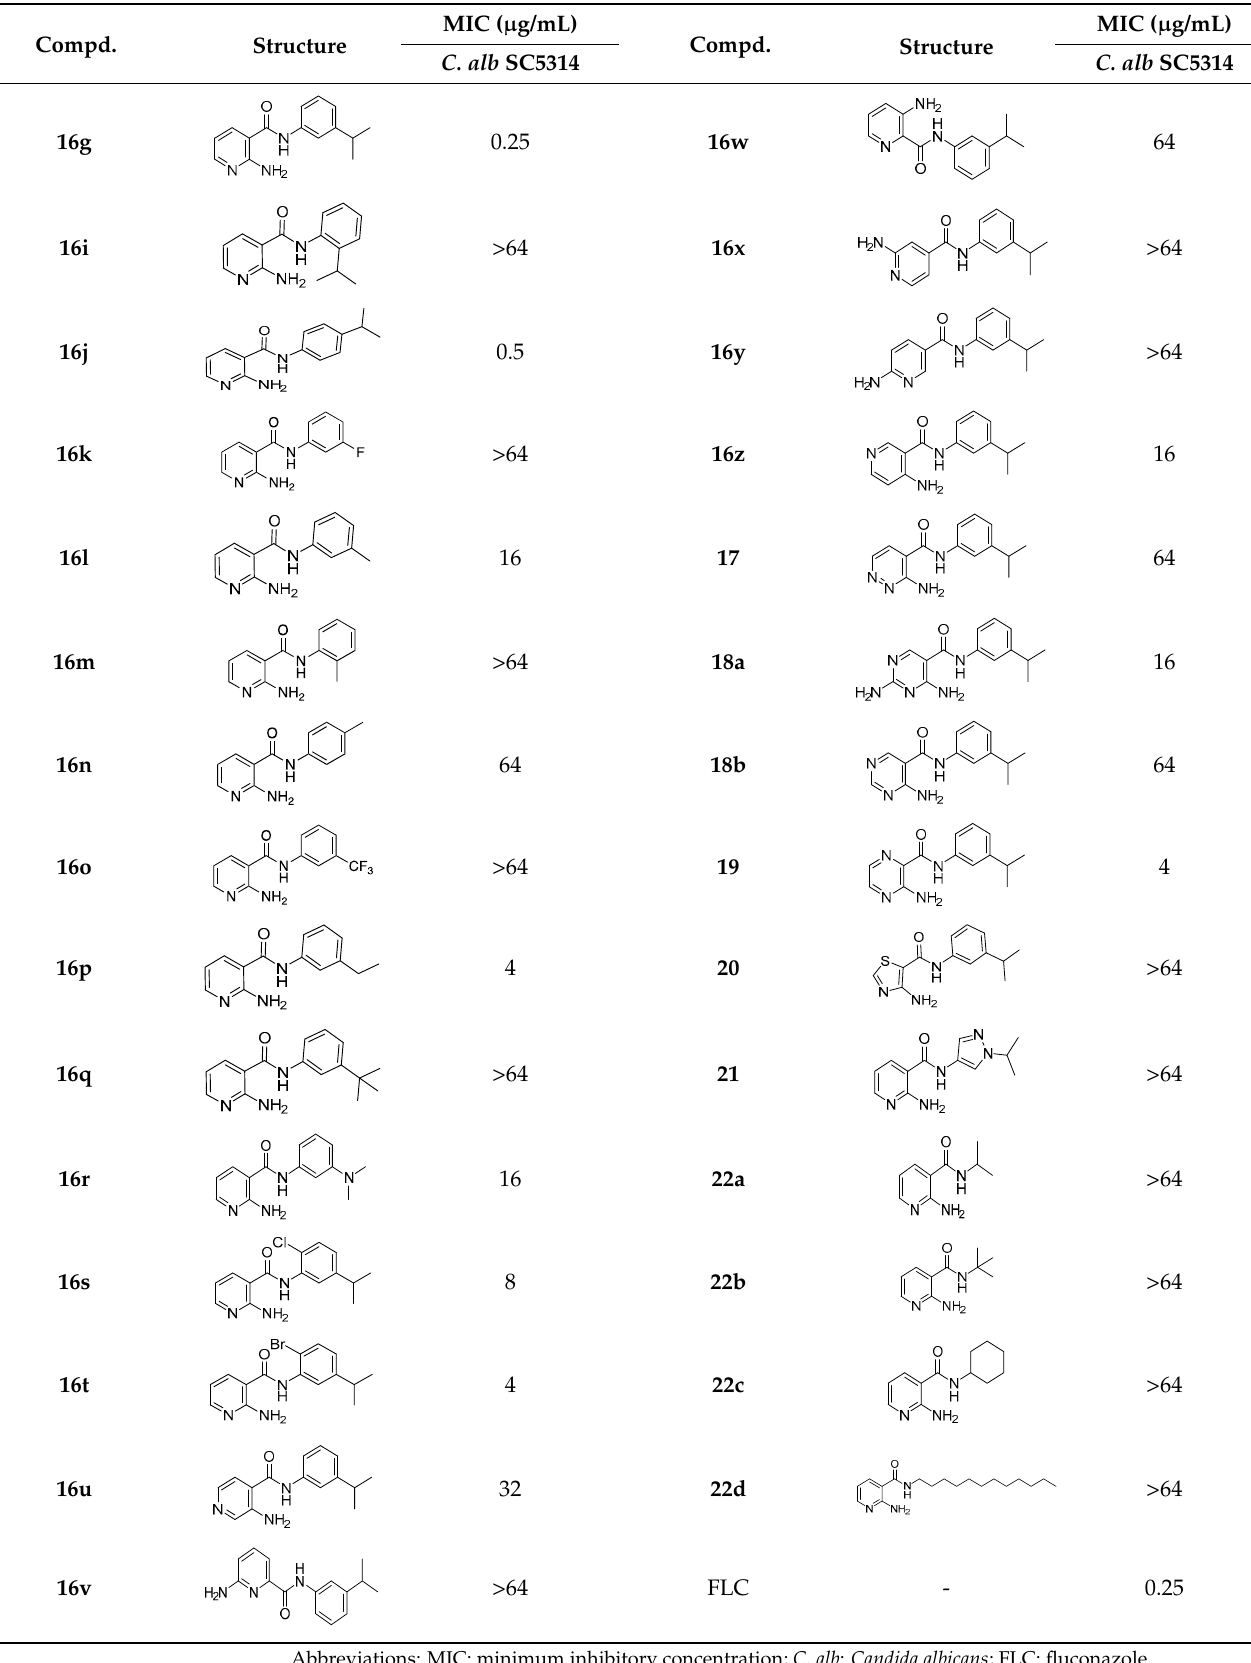
Table 2. In vitro antifungal activities of compounds against C. albicans SC5314. Compd.